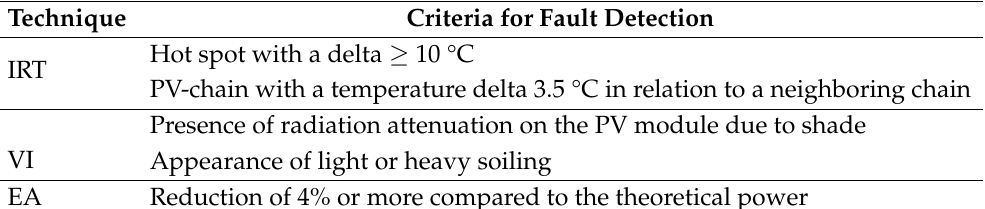
Table 3. Criteria used for each technique evaluated to detect the failures induced from each subopti- mal